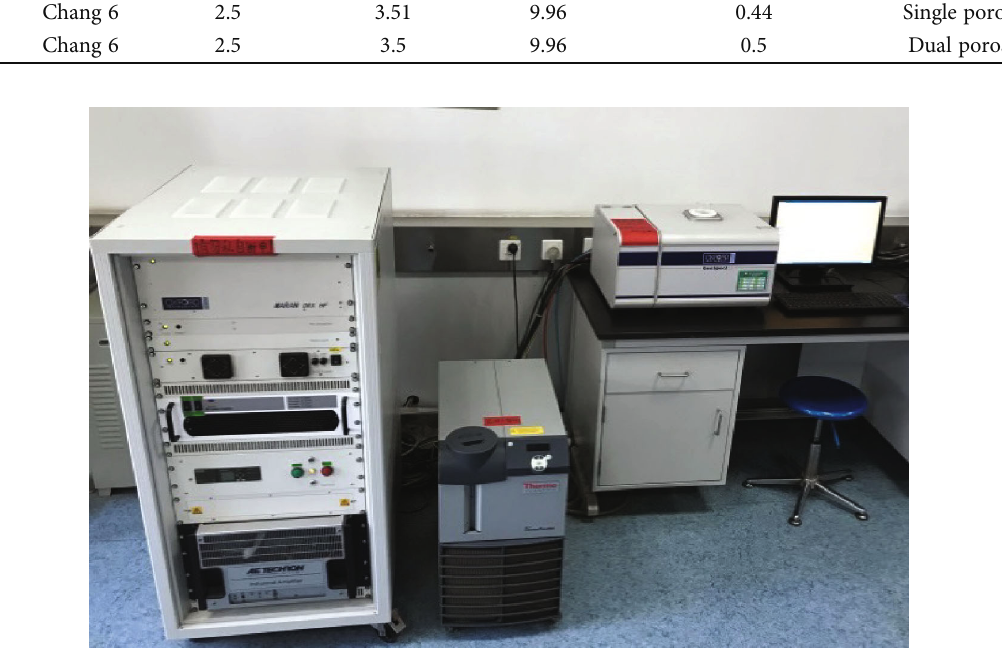
Figure 1: Oxford Geospec 2/53 NMR instrument.